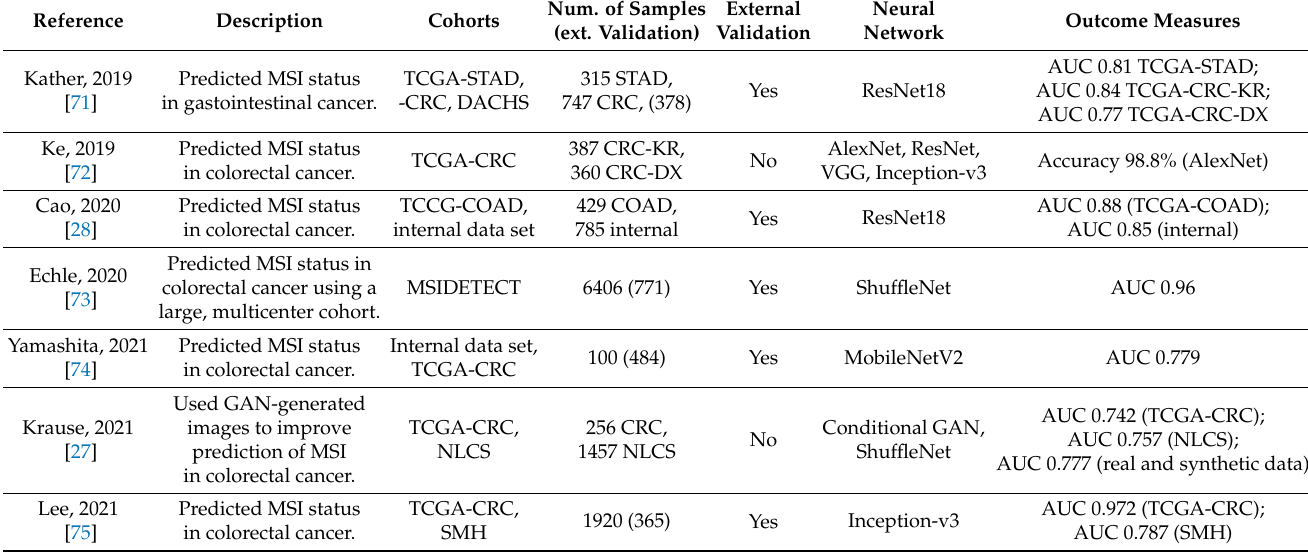
Table 4. Comparison of studies aimed at predicting microsatellite instability from digitised histopathology slides using deep